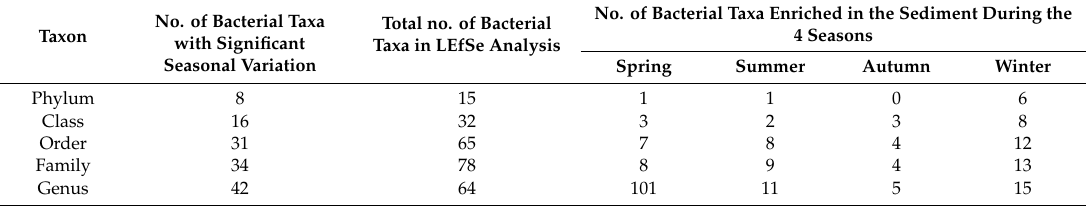
Table 2. The phylogenetic distribution of bacterial lineages associated with the 4 seasons of a year. No. of Bacterial Taxa Enriched in the Sediment During the No. of Bacterial Taxa Total no. of Bacterial 4 Seasons Taxon with Significant Taxa in LEfSe Analysis Seasonal Variation Spring Summer Autumn Winter Phylum 8 15